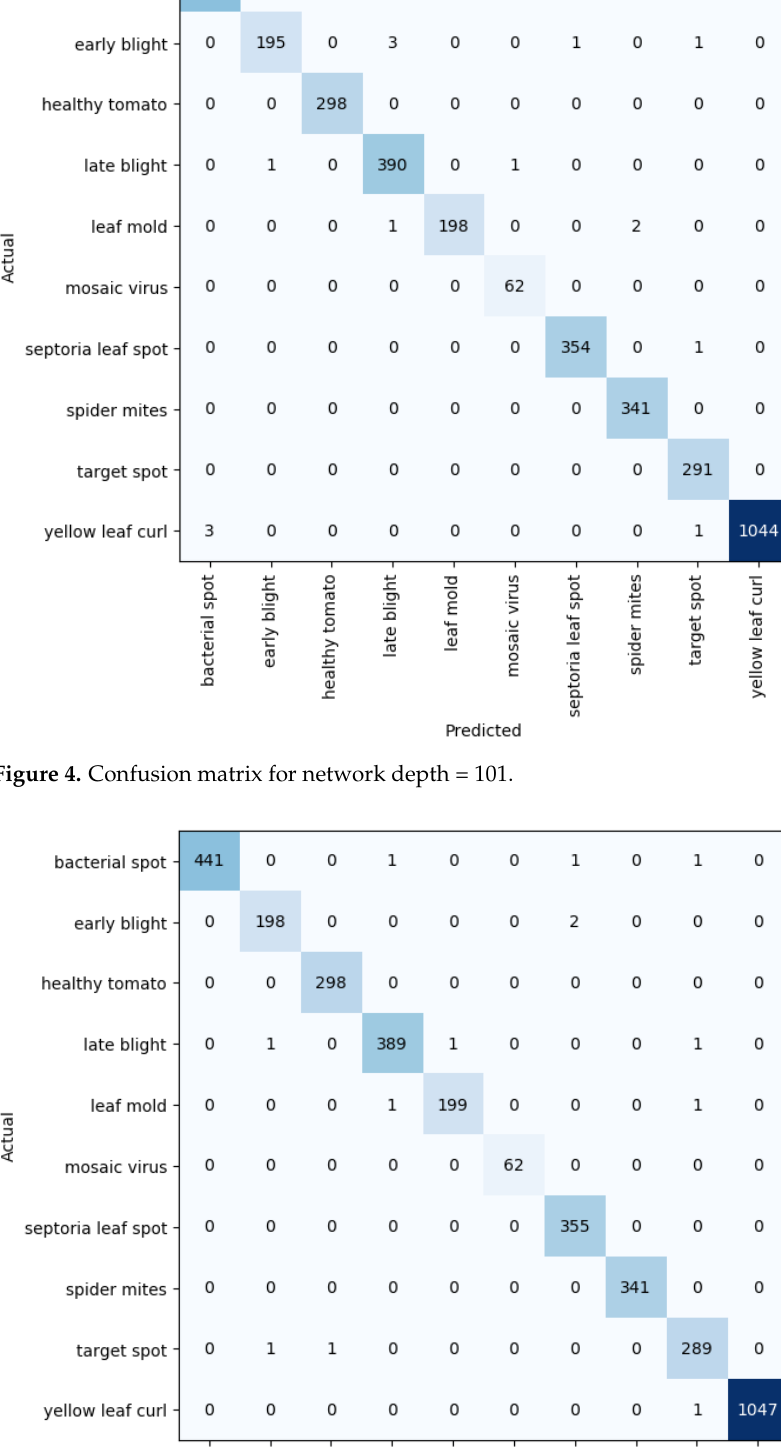
Figure 3. Confusion matrix for network depth = 50.